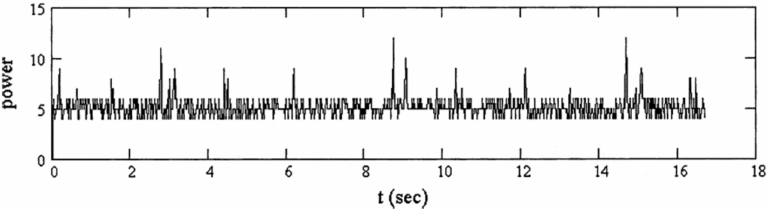
Figure 25. Echo intensity of the object 1990-061A registered at Bear Lakes during the first differential interferometer experiment in 2001 [68]. Reprinted from Advances in Space Research, Copyright 2004, with permission from